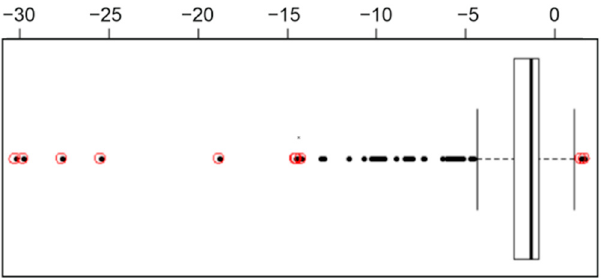
Figure 9. Boxplot of the joint dataset. Red circles show the outliers that have been removed because they conflict with neighboring values.